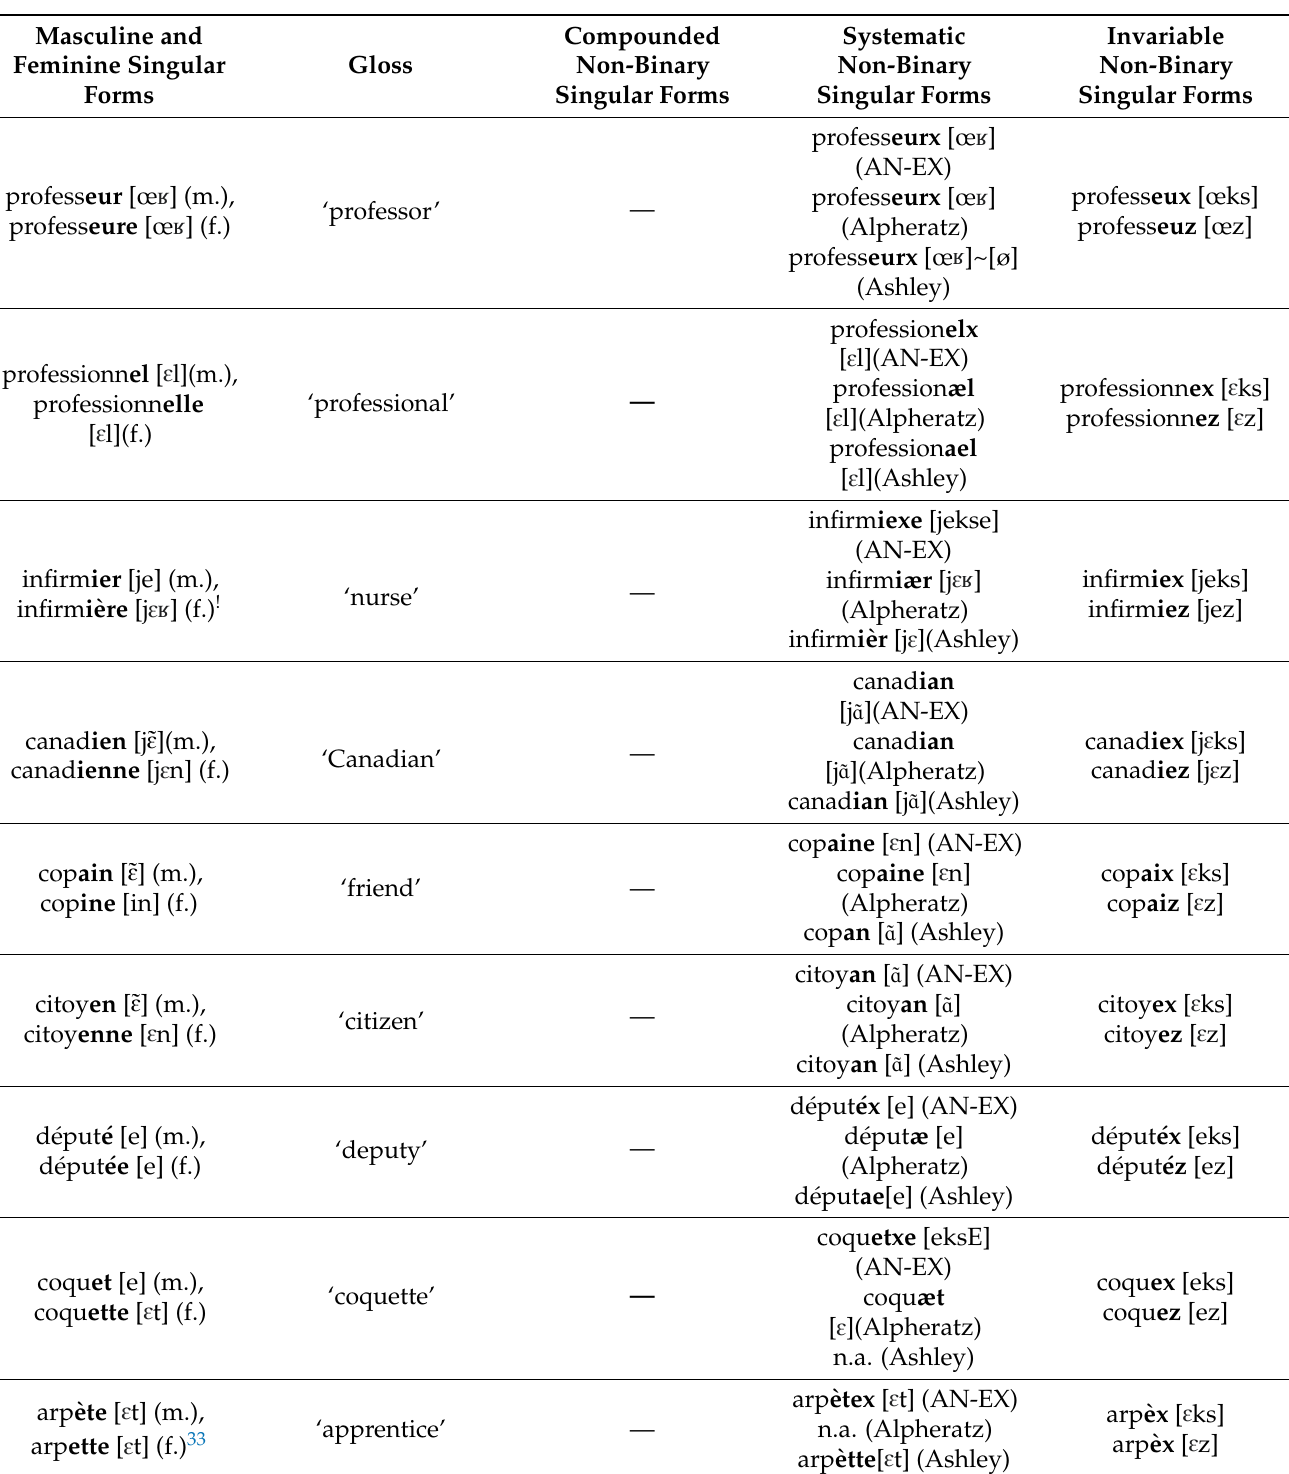
Table 1. Gender and Number Distinctions in Written and Oral French.